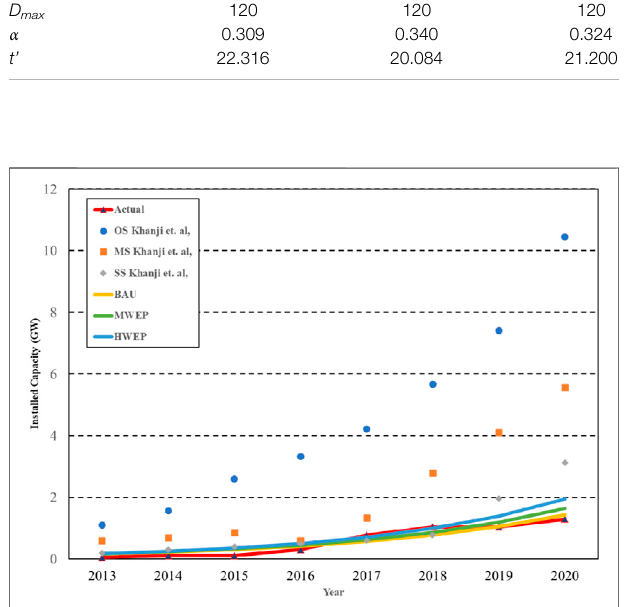
FIGURE 6 | Model comparison and validation with existing